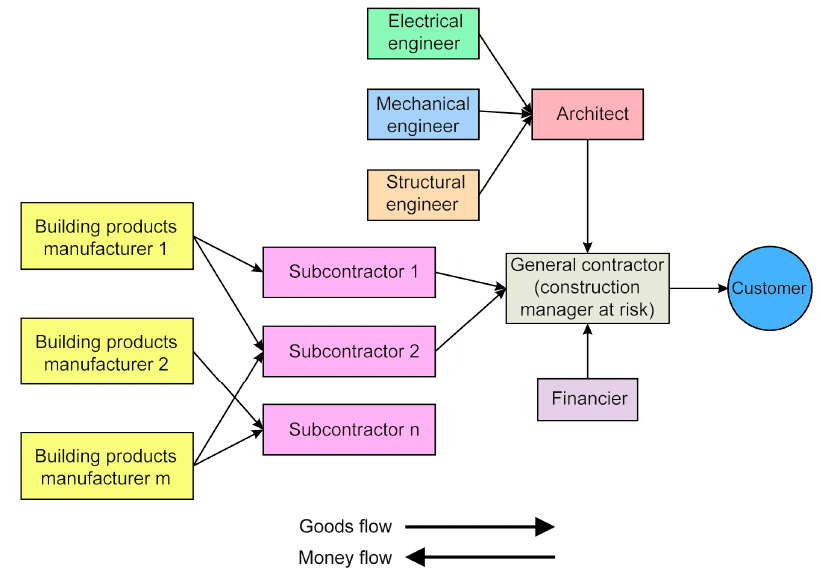
Figure 2. The framework of construction supply chains presented by O’Brien et al. [9].